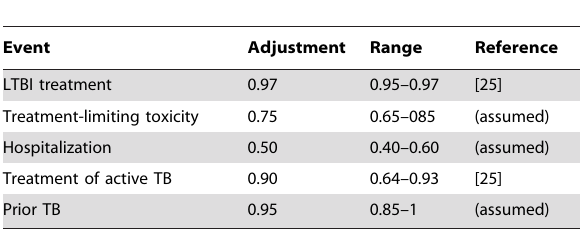
Table 2. Utility adjustments for events occurring in the model, expressed as fractions of a